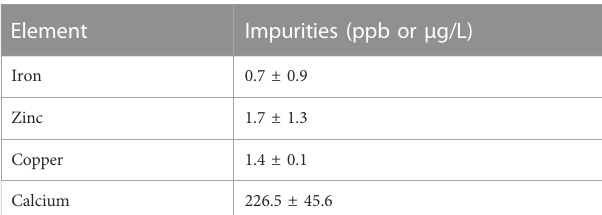
TABLE 6 Trace metals analysis of an eluted fraction of 43/44g Sc using MP-AES.